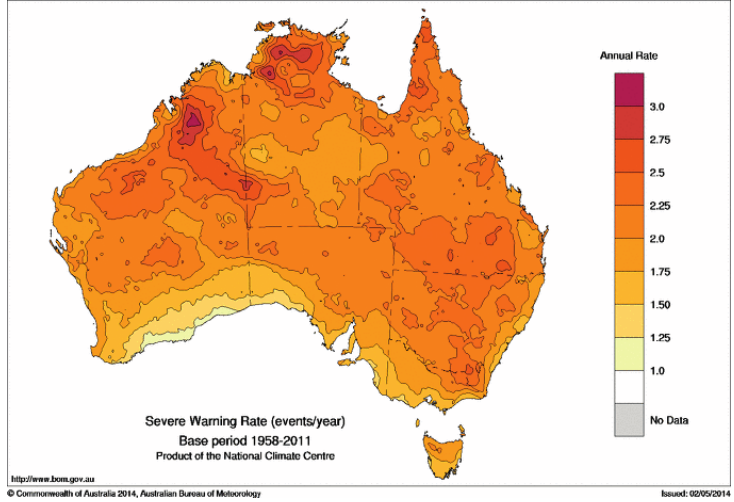
Figure 9. Average annual occurrence of TDPs with EHF above the severity threshold EHF in the period 1958–2011. Values are expressed in the form of TDPs per year. 85